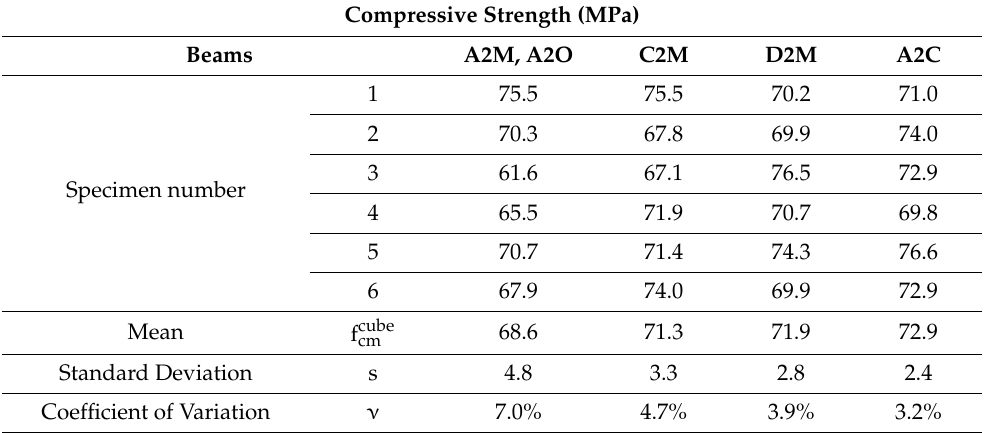
Table 4. Compressive strength results for concrete cubes.